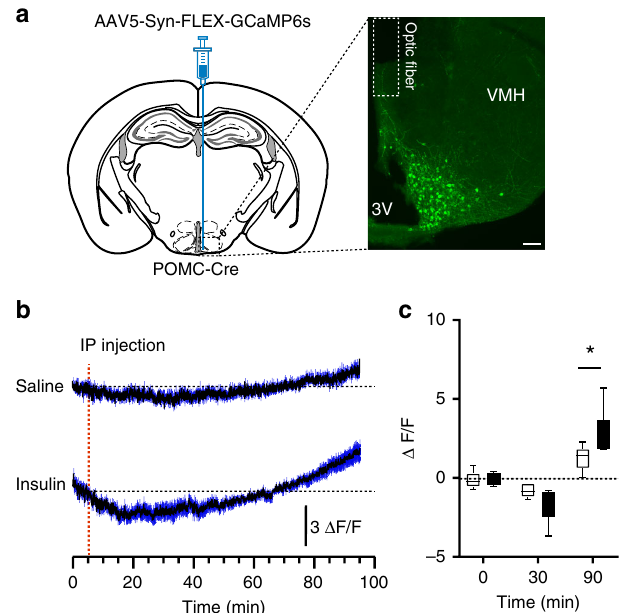
Fig. 6 Insulin-induced hypoglycemia increases calcium signal in ARC POMC neurons. a Schematic illustration of the experimental con fi guration. We injected AAV5-Syn-FLEX-GCamp6s viruses into the ARC of POMC- Cre mice (left panel). Right panel shows the expression of GFP in ARC POMC neurons in mice injected with these viruses into the ARC. Scale bar: 100 µ m, 3V, third ventricle. b Average of normalized ARC POMC neuron calcium signal in mice treated with saline and insulin (2 U/kg) ( n = 6 mice, respectively). Insulin-induced hypoglycemia caused an increase in calcium signals approximately 1 h post i.p. insulin injection. Dark blue lines represent error bars. Source data are provided as a Source Data fi le. c Summary plot showing changes in normalized ARC POMC neurons calcium signal over time in mice treated with saline and insulin (signi fi cance assessed using a two-way ANOVA followed by Sidak multiple comparisons test, 90 min, ** p = 0.006). All data are shown as mean ± SEM. Source data are provided as a Source Data fi